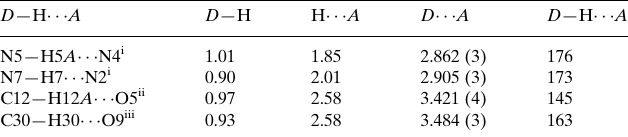
Hydrogen-bond geometry (A ˚ , (cid:2)